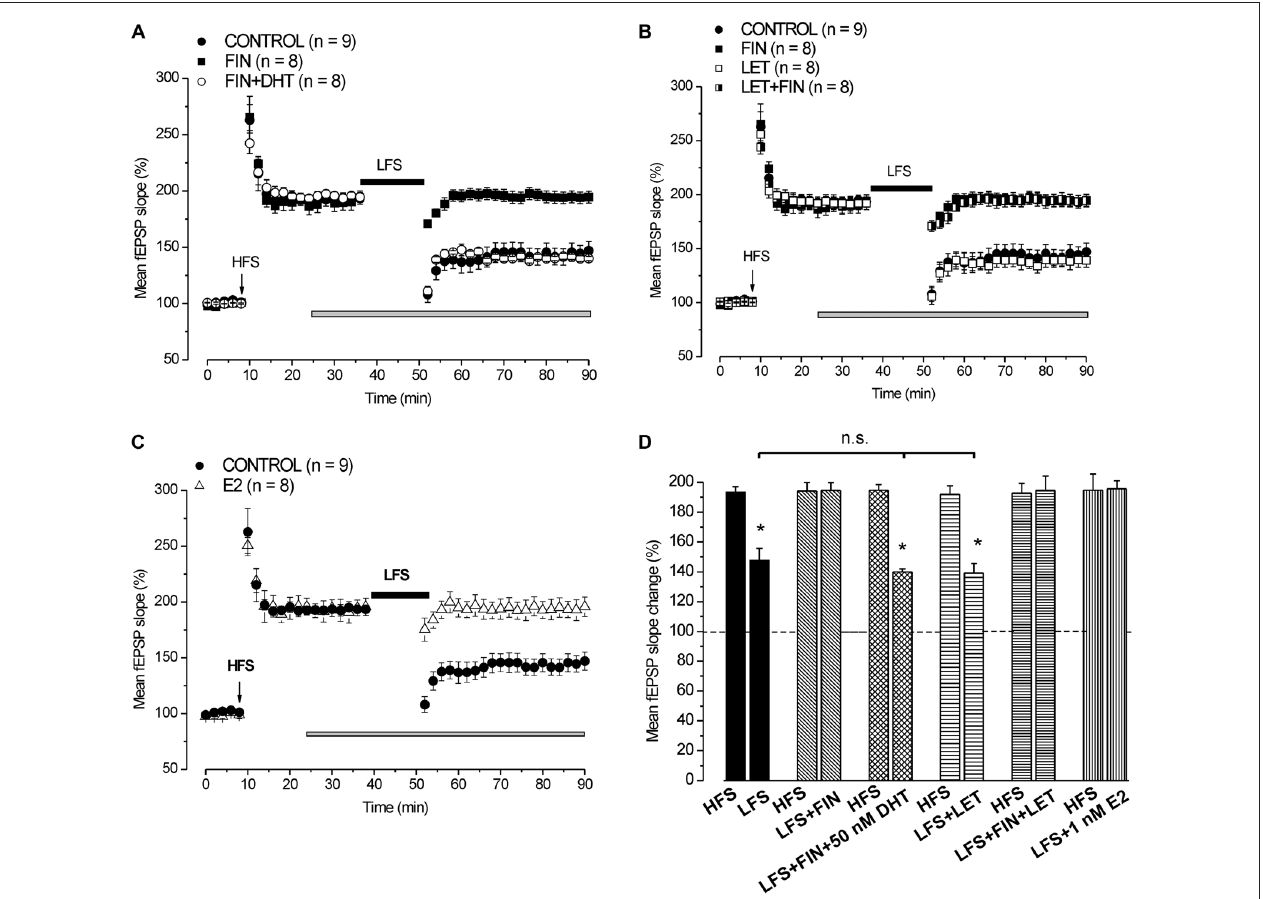
FIGURE 3 | Neo-synthesis of DHT is involved in the induction of DP by LFS. (A) Effect of LFS in control condition (filled circles), under FIN (filled squares) and FIN + 50 nM DHT (open circles). (B) Effects of LFS in control condition (filled circles), under FIN (filled squares), LET (open squares) and FIN + LET (half-filled squares). (C) Effect of LFS in control condition (filled circles) and in the presence of 1 nM E2 (open triangles). The drugs were applied 15 min after the induction of HFS-LTP and LFS was delivered 30 min after HFS. In this and following figure the arrows indicate the HFS delivering time. (D) Comparison between HFS-LTP and LFS-DP in different conditions as shown in (A–C) (Student’s t test, ∗ p < 0.05). The LFS-DP values in control condition and under different drugs are compared (one-way ANOVA, F 2,22 = 0.049, p = 0.95). Note that the synthesis of DHT, but not that of E2, is required for the induction of LFS-DP, while exogenous E2 is able to prevent the